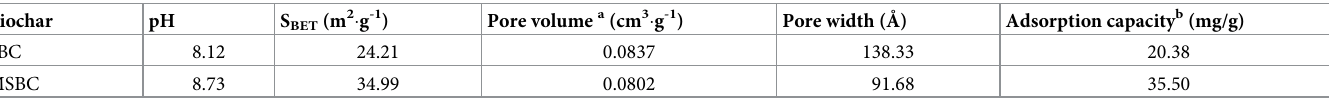
Table 1. Pore distribution properties and Ni adsorption capacity of SBC and MSBC.